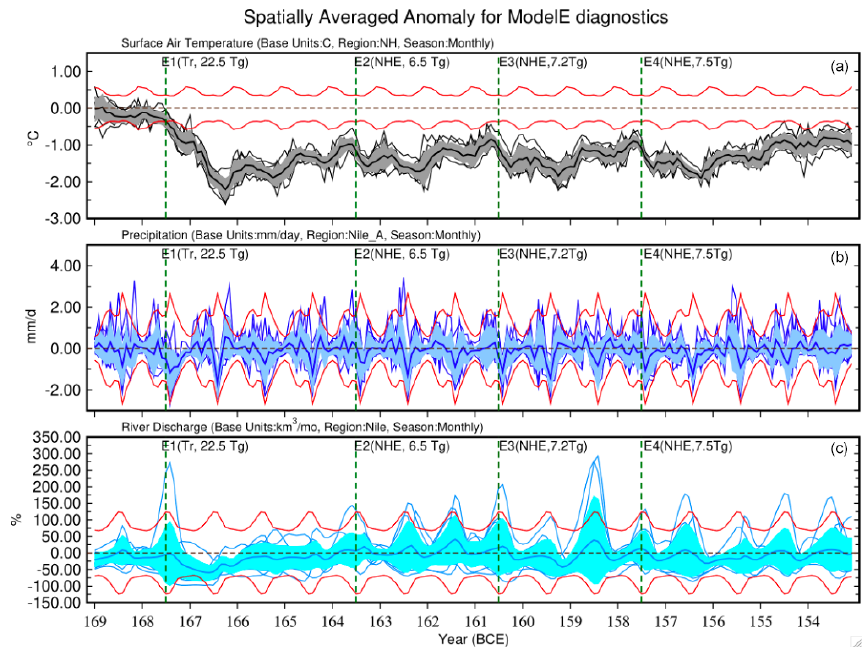
Figure 12. Monthly time series of individual ensemble and mean of surface temperature response ( ◦ C) averaged over Northern Hemi- sphere (NH) (a) , rainfall change (mmd − 1 ) for the model’s spatial box representing the Nile River watershed – latitude: (5, 18 ◦ N), longitude: (30, 42 ◦ E) – (b) and Nile River discharge anomaly (%) at the delta region (grid box centered at 29.0 ◦ N, 31.25 ◦ E) (c) . For each panel, the darker solid (thick) line shows the multi-ensemble mean, individual member (thin lines), and the color envelope shows the associated variability ( ± σ ; standard deviation). The annual cycle of climate variability of the control run is shown as 2 σ ctrl lines (red solid line) along the x axis for all three variables. The vertical dotted green lines show when each eruption